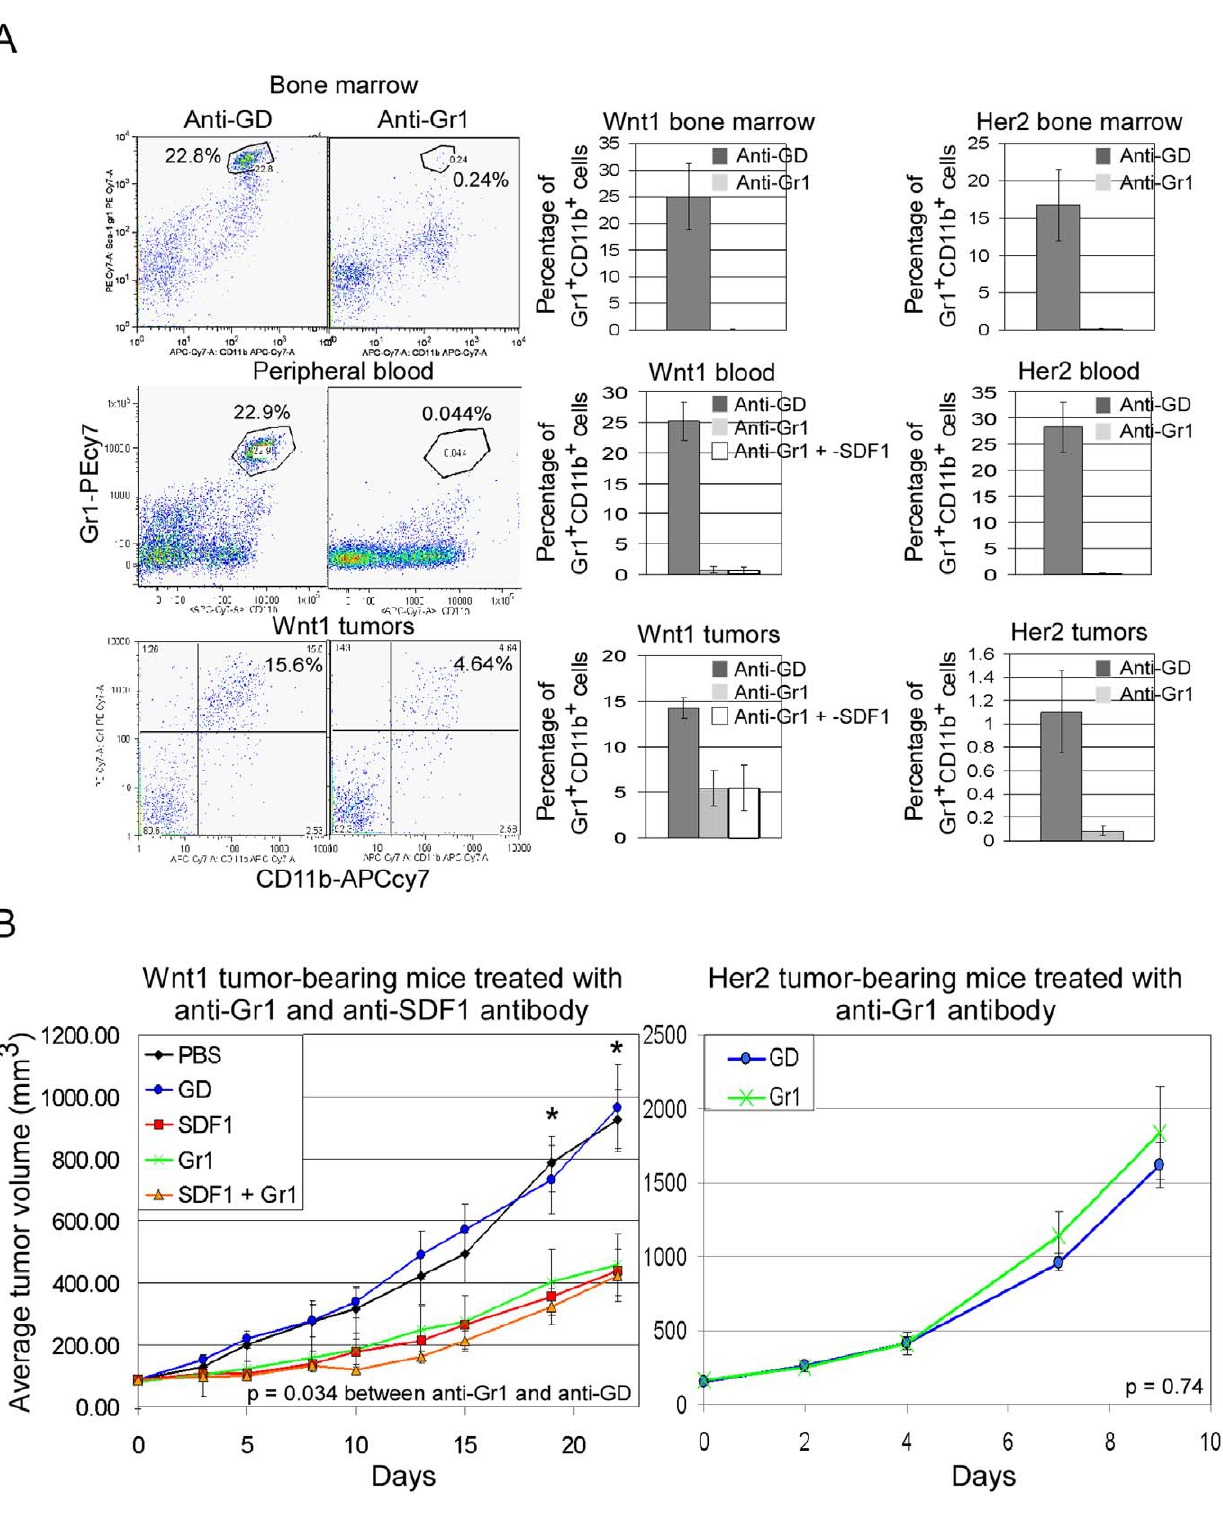
Figure 6. Tumor-bearing mice treated with anti-Gr1 and anti-SDF1 antibody. A, FACS profiles and histogram plots of percentage of Gr1 + CD11b + cells in the bone marrow, peripheral blood, and tumors of Wnt1 and Her2 tumor-bearing mice treated with anti-GD (dark bars), anti-Gr1 (light bars), or anti-Gr1 and -SDF1(white bars) antibody. Error bars represent standard deviations derived from analysis of three independently treated mice. B, average tumor volumes of Wnt1 (left panel) or Her2 (right panel) tumor-bearing mice treated with controls, PBS (black) and anti-GD (blue), and with anti-SDF1 (red), -Gr1 (green) and both -SDF1 plus -Gr1 (orange) antibodies. Average tumor volume was determined from n=5 mice per treatment group, and error bars represent + / 2 SEM. * indicates average tumor volumes that are statistically different between anti-GD and anti-Gr1 treatment groups (p , 0.05).